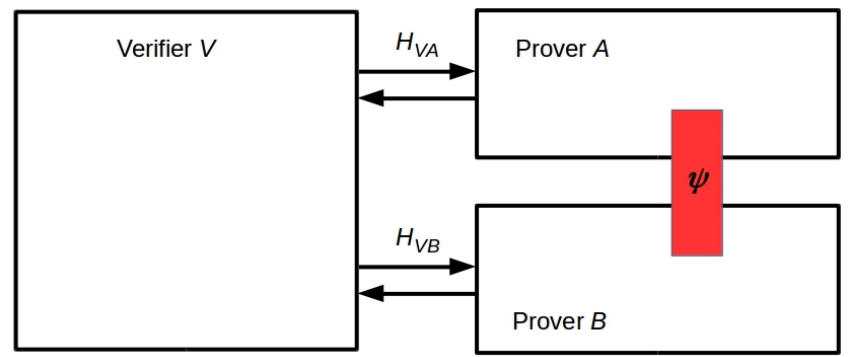
Figure 2. An interactive proof system with two otherwise noninteracting provers ( A and B ) that share an entangled state ψ (red rectangle). The verifier interacts separately with the two provers. This is the set-up used in Reference [26] to prove Multiprover Interactive Proof* (MIP*) = RE, and hence that the Halting Problem (HP) can be solved by interactive proof with entanglement as a